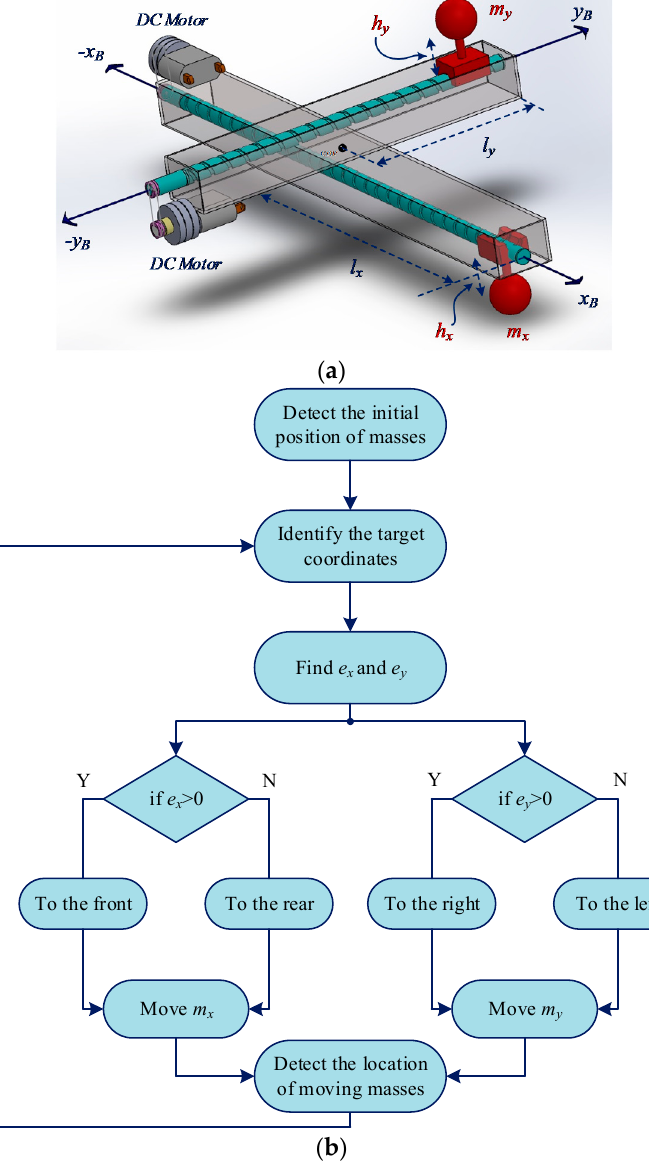
Figure 8. ( a ) Model of the up-down motion mechanism; ( b ) Flow chart of the up-down motion. When mass positions change, pitch and roll torques are generated. These mentioned torques are considered in Equations (10) and (11), respectively.